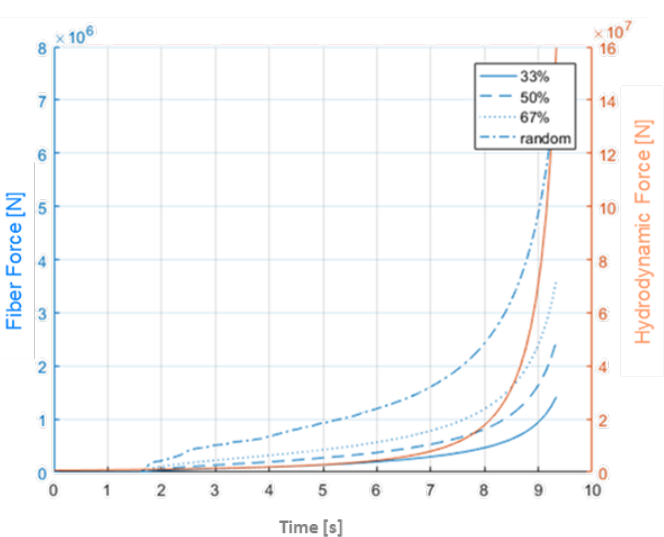
Figure 11. Development of fiber forces with different orientation distributions (blue) and hydrodynamic forces (red) during compression molding .